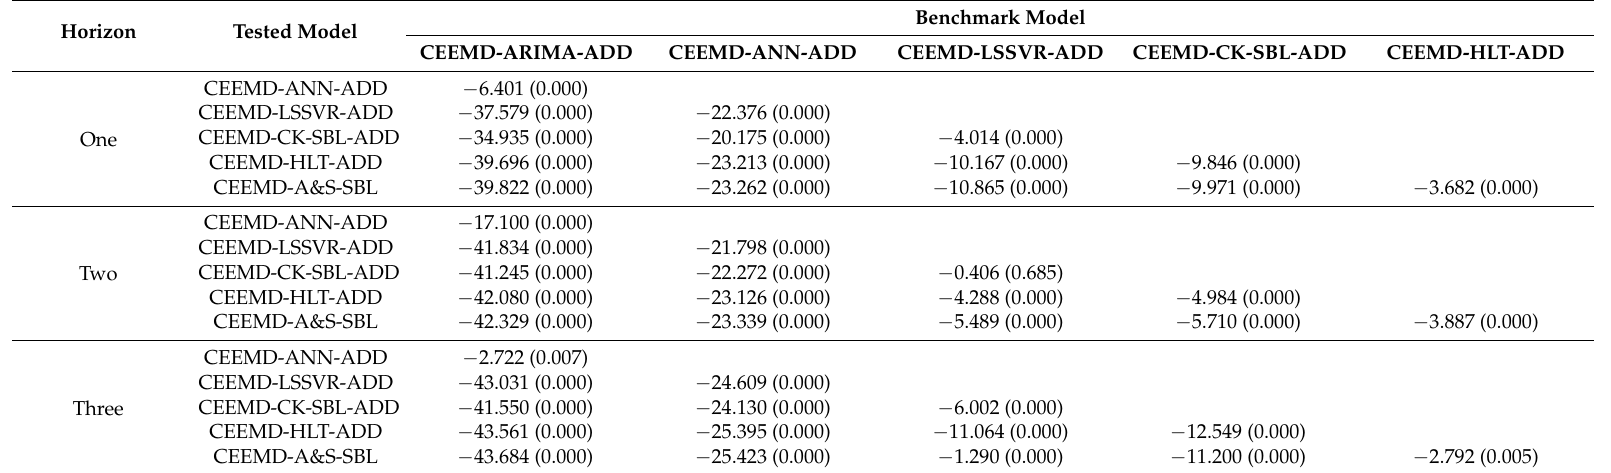
Table 6. The Diebold–Mariano (DM) test results on WTI crude oil prices.